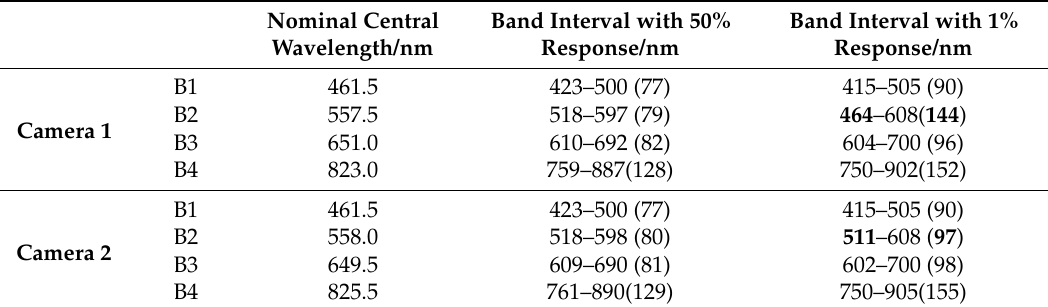
Table 1. Band specifications for the two cameras of HY-1C CZI. The nominal center wavelengths (defined as the center of the 50% peak response) and band intervals with 50% (1%) peak response are determined from the spectral response functions. The specifications for the two cameras are found to be almost identical with exceptions in the green band, shown as bold